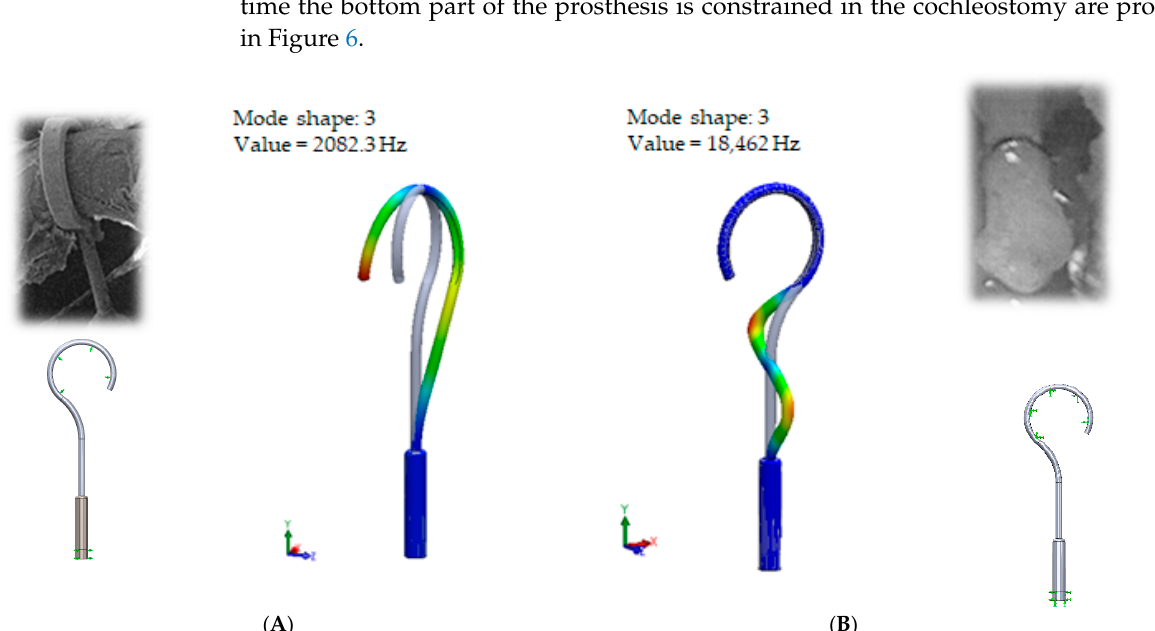
Figure 5. The results of modal analysis: the fixation of the loop of standard stapes prosthesis on the incus long process with free piston. ( A ) standard (target) fixation of the loop of prosthesis. ( B ) over constrained fixation of the loop of prosthesis (for example, in case of necrosis).